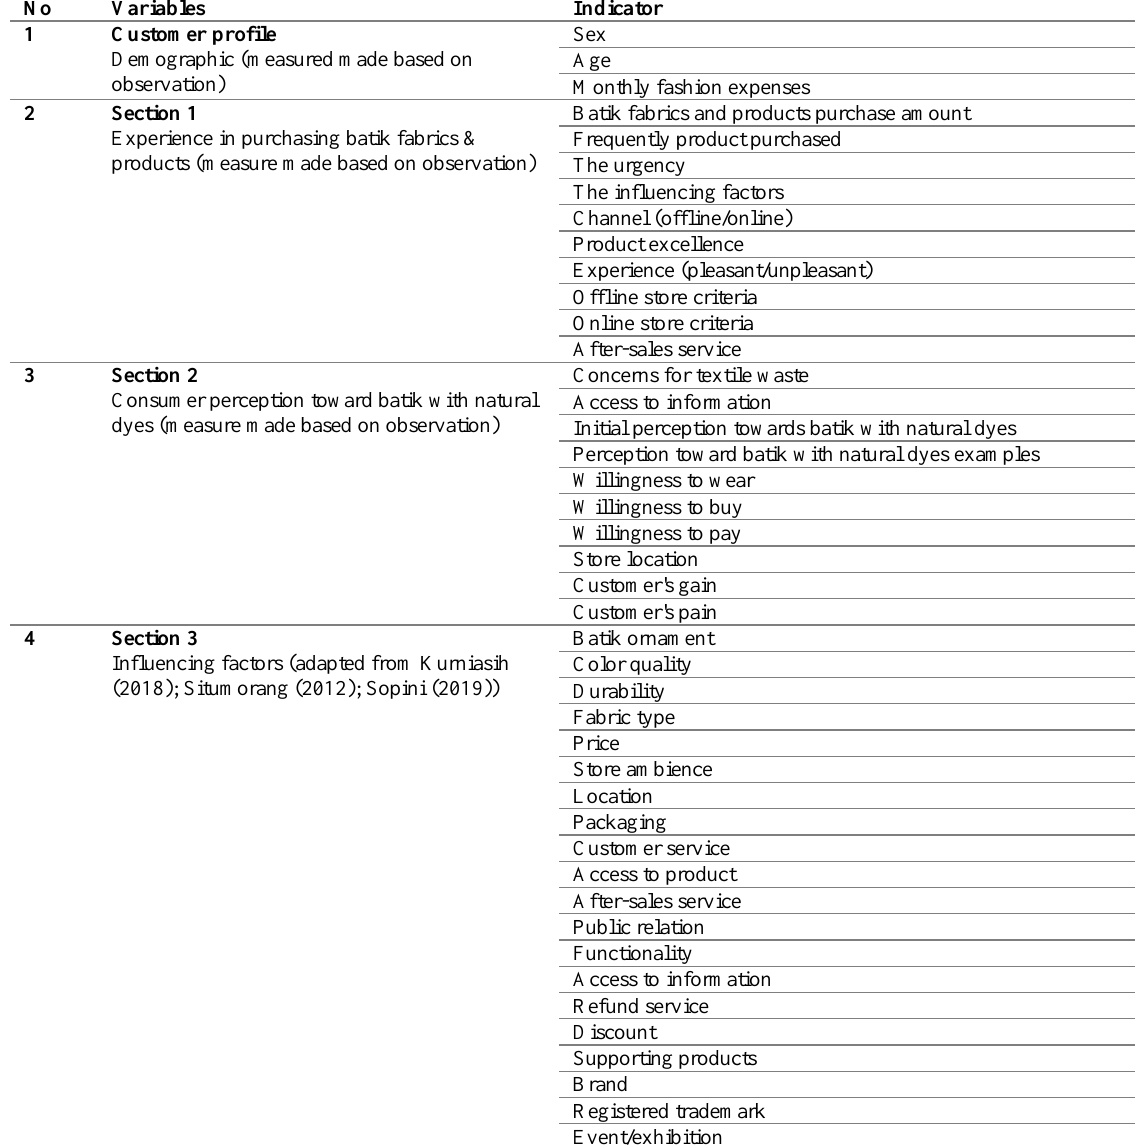
Table 1: Consumer Behavior